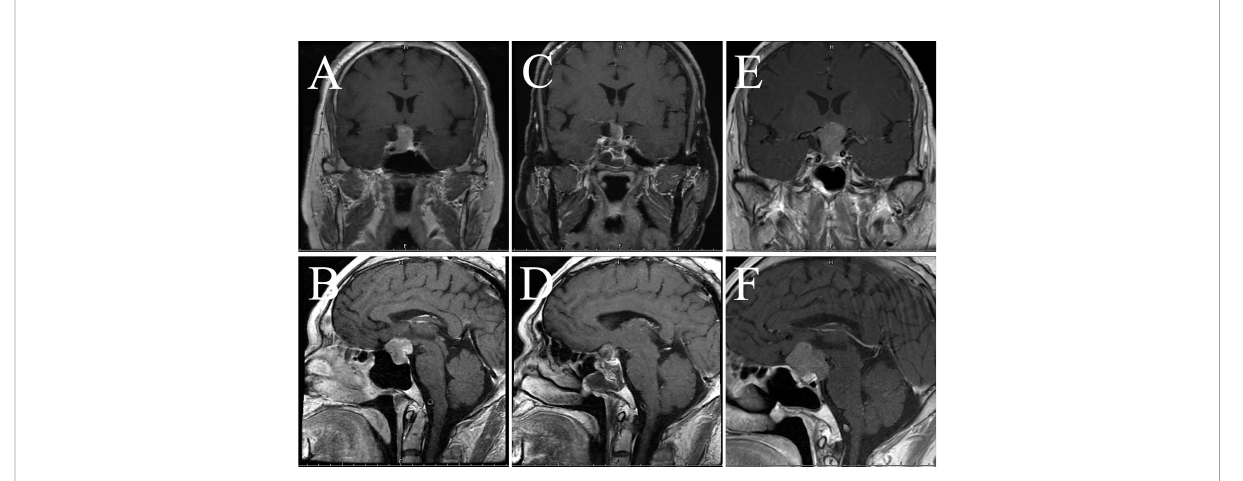
FIGURE 4 Imaging data of case 2. The images show coronal and sagittal MRI of the patient ’ s head preoperatively (A, B) , three months postoperatively (C, D) , and twenty-one months postoperatively (E, F) , respectively.